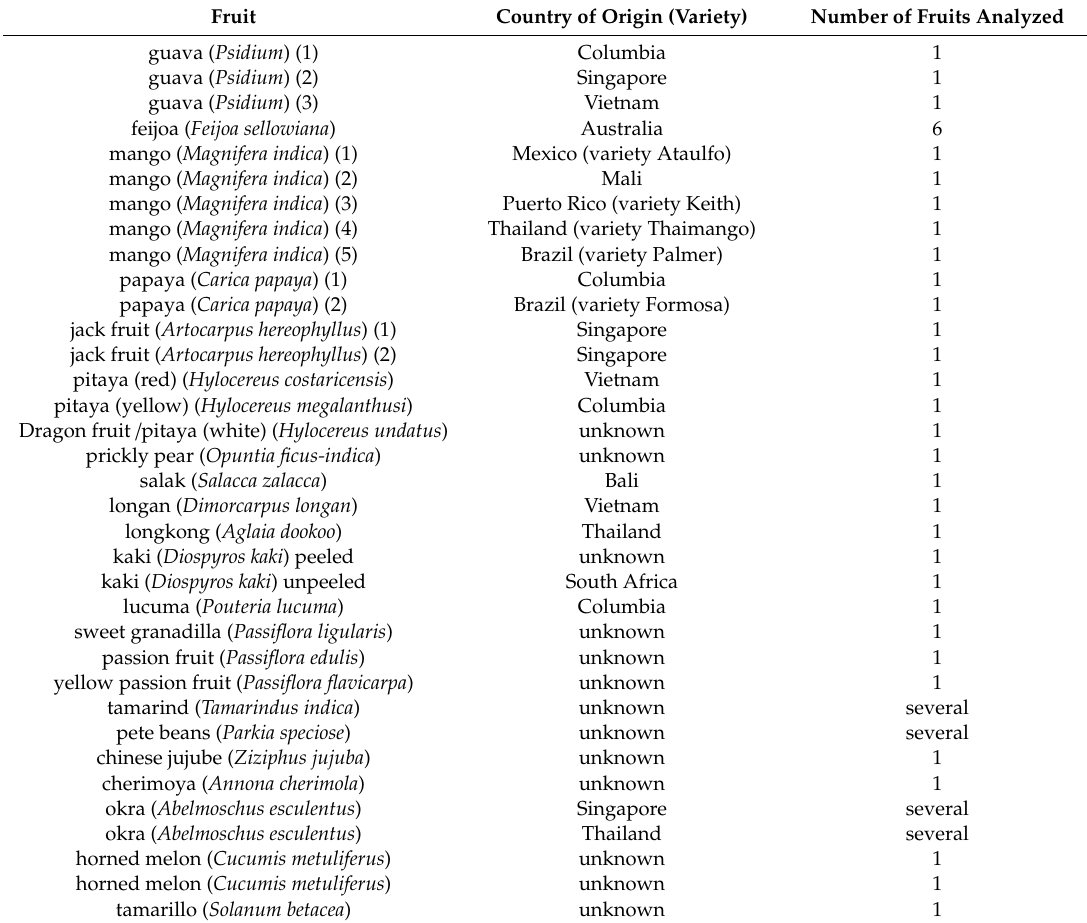
Table A1. List of countries of origin and number of fruits analyzed of all fruits listed in the